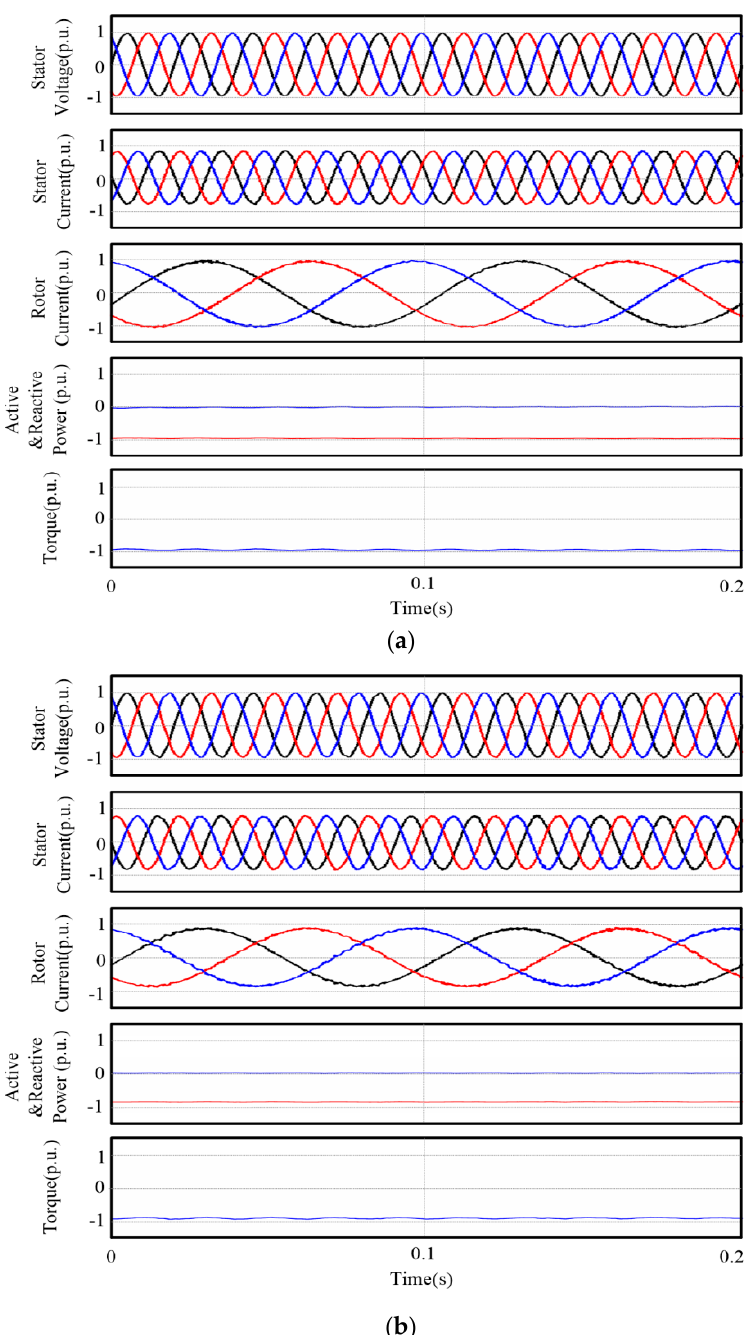
Figure 22. Simulation results of DFIG system in weak grid with improved PLL (a) Low bandwidth, and (b) High bandwidth.